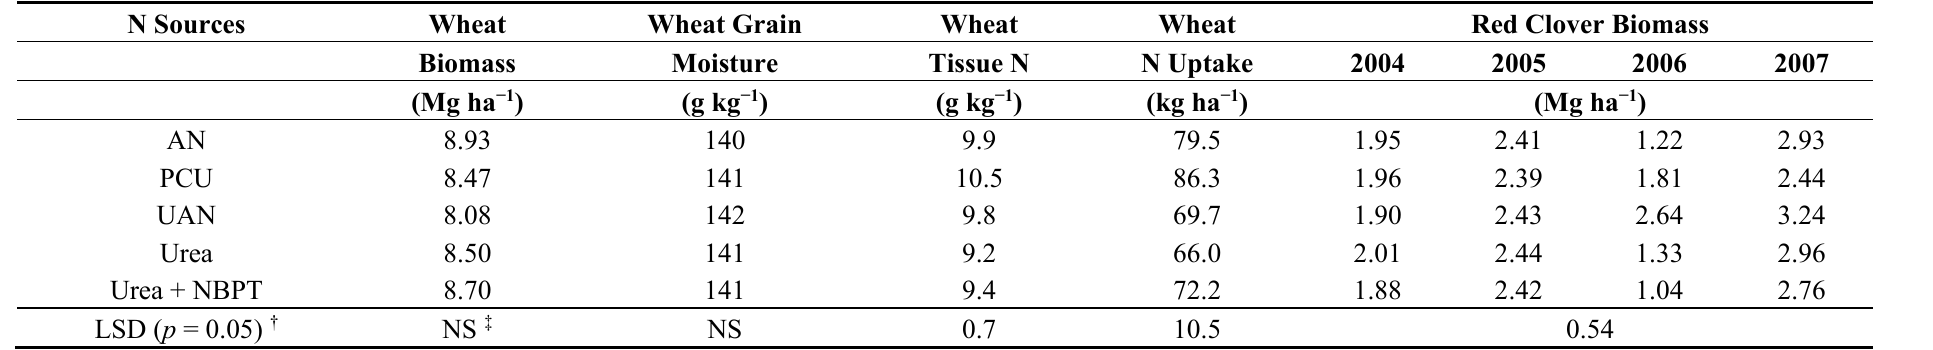
Table 4. Effect of fall- and split-applied nitrogen sources on wheat plant biomass, grain moisture, tissue N, wheat N uptake, and red clover biomass dry matter; nitrogen sources were applied at 112 kg N ha − 1 and included AN, ammonium nitrate; PCU, polymer-coated urea; UAN, urea ammonium nitrate; urea; and urea plus NBPT. Data were averaged over N application timing (fall and split) and years in the absence of a significant interaction.